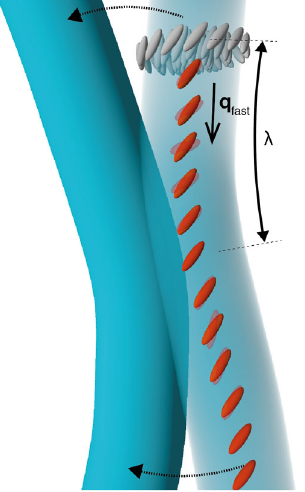
FIG. 3. Graphic illustration of fast and slow fluctuation modes in the BPIII phase. The slow mode represents positional and contour fluctuations of skyrmion filaments as a whole. The fast BPIII mode represents elastic deformation of the internal director structure of the filaments. This picture is to be considered as a conjecture